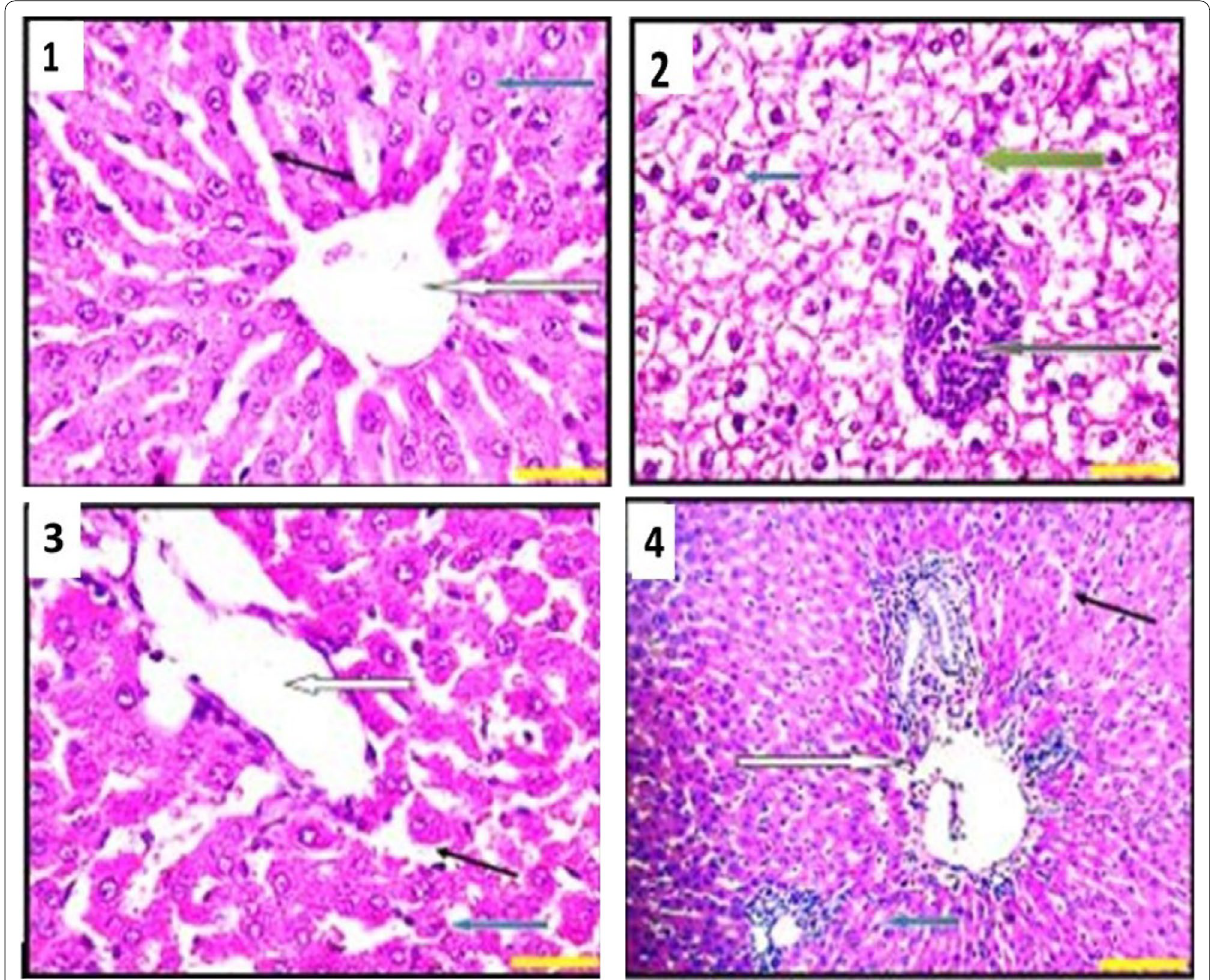
Fig. 6 Photomicrographs of liver section demonstrated by Haematoxylin and Eosin staining at low magnification (200 µm). The hepatocytes, sinusoids, portal triad (hepatic vein, hepatic artery and bile duct) are all visible across the various groups. 1 (control), 2 group that received arsenic only, 3 =